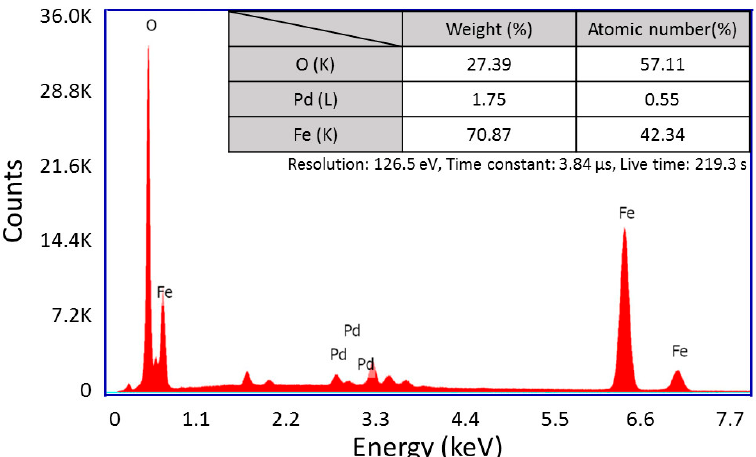
Figure 3. Energy dispersive X-ray spectrometry (EDS) spectra of the nanoparticles we prepared. Inserted table shows percent by weight and number of atoms for each element.